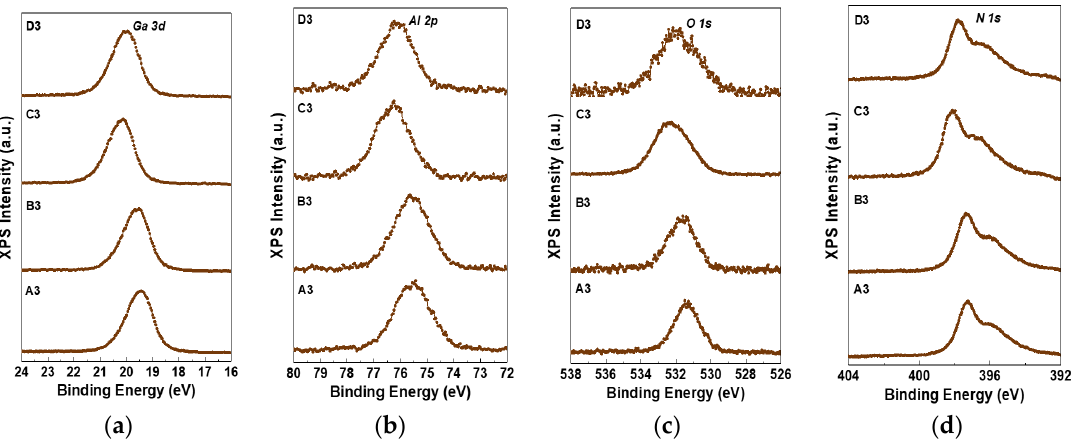
Figure 3. XPS spectra of ( a ) Ga 3d, ( b ) Al 2p, ( c ) O 1s, and ( d ) N 1s core levels at 3 nm Al 2 O 3 /GaN interfaces with PDA conditions: no anneal (A3), 500 °C for 3 min (B3), 700 °C for 3 min (C3), and 900 °C for 3 min (D3).